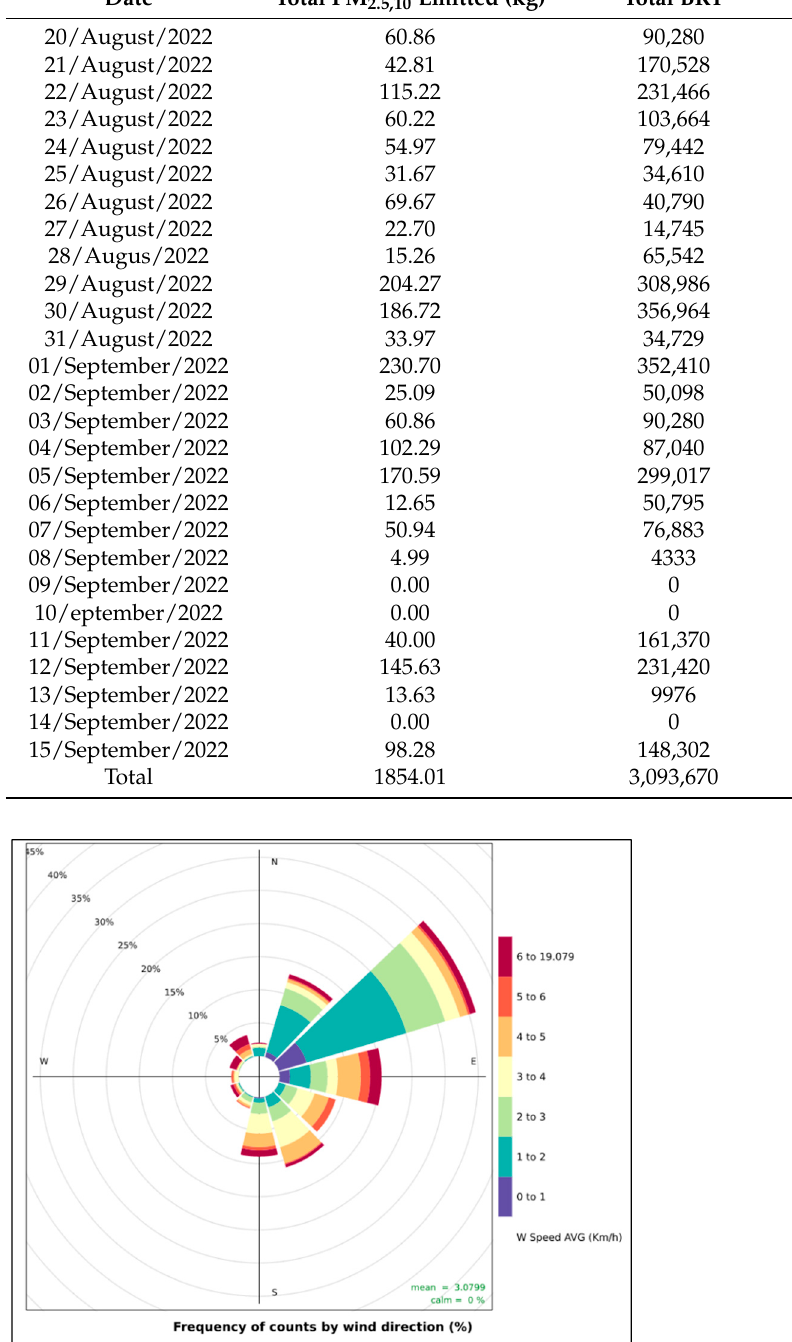
Figure 7. Average concentrations of PM for 4 measurement locations over the experimental period 20 August–15 September 2022. Over a period of sun and clouds with low wind speed weather, higher concentrations of PM 10 (Figure 8a) and PM 2.5 (Figure 8b) were recorded. On the other side, higher winds and rain precipitation significantly influenced the decrease in PM daily mean values, as shown in Figure 8. Bivariate polar plots with wind direction presented on a radial scale provide infor- mation about the potential emission sources of analyzed air pollutants [31]. Using Openair tools [32], the PM 2.5 and PM 10 concentration distribution in the experimental period from 20 August to 15 September 2022 was presented for the K4 measuring location as a function of wind speed and direction (Figure 9). The K4 station was selected due to the highest measured average concentration of PM 10 and PM 2.5 during the experimental period. Fig- ure 9 demonstrates that higher levels of PM are associated mainly with low wind speed and the inflow from nearby anchorages A2 and A1 during the hoteling phase and posi- tioned ENE (A2) and SE (A1) from the station.